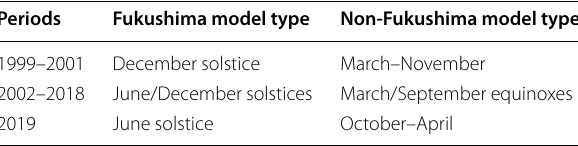
Table 1 Year and month of the dusk-side IHFAC suggested